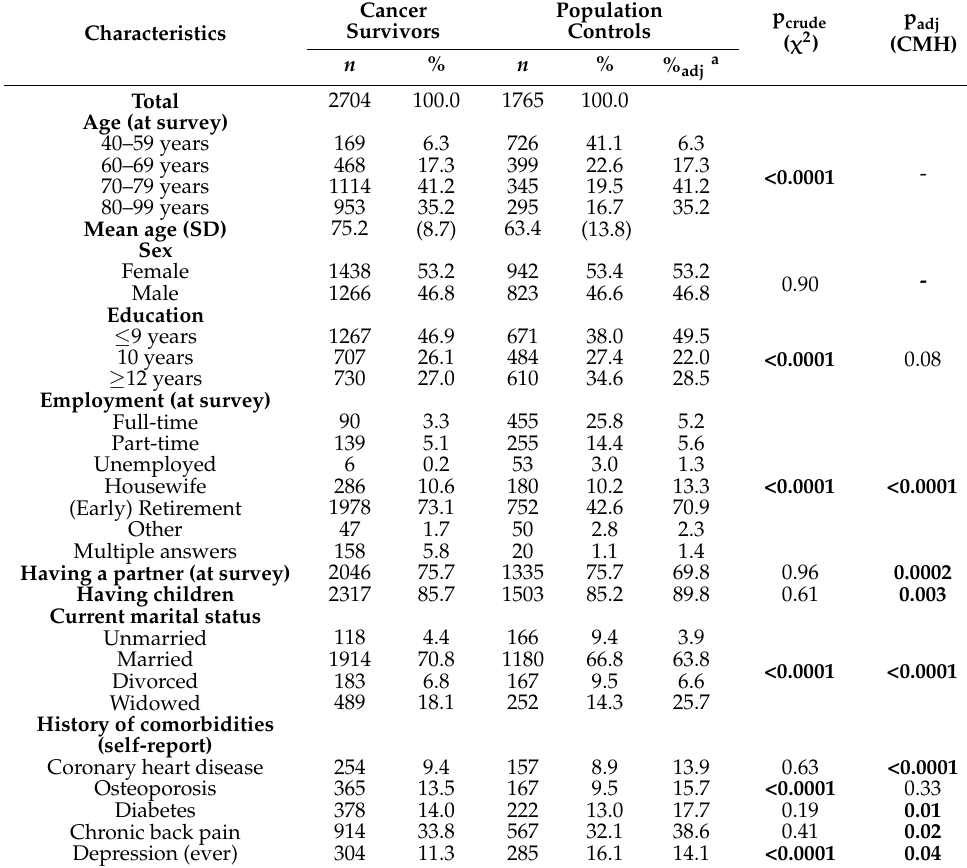
Table 1. Characteristics of very long-term cancer survivors and population